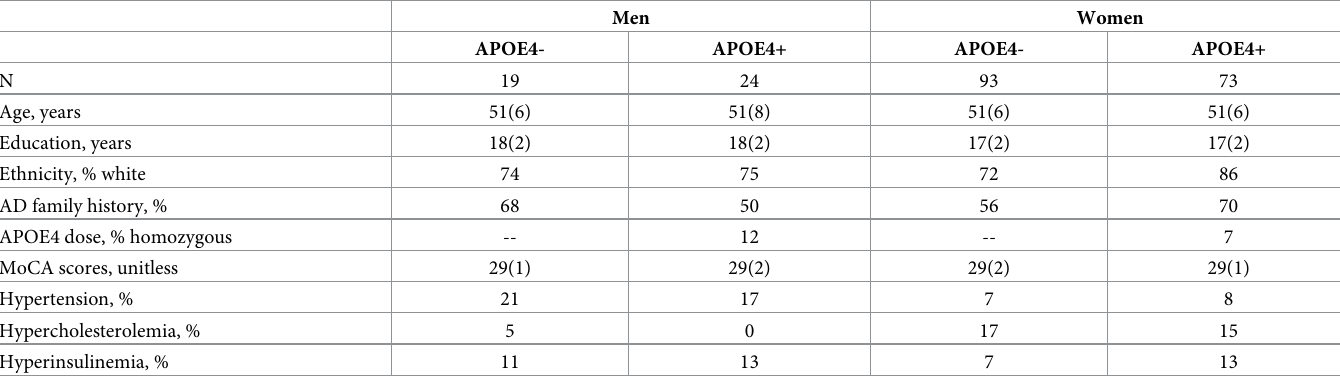
Table 1. Participant